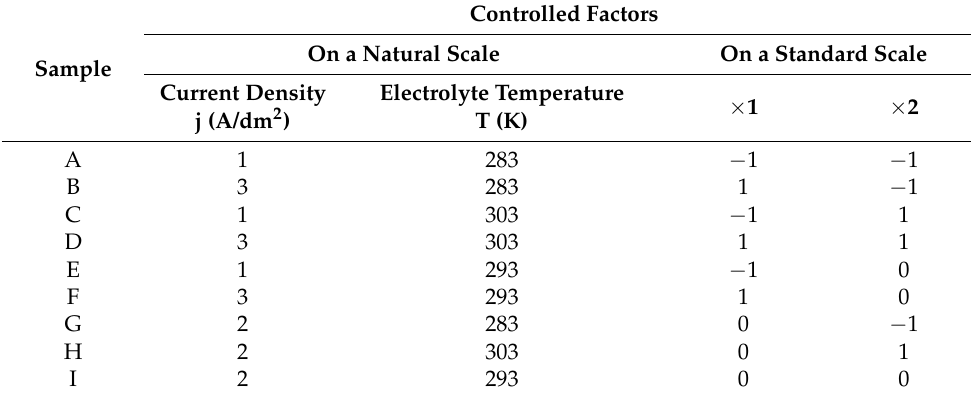
Table 1. Total experiment plan.